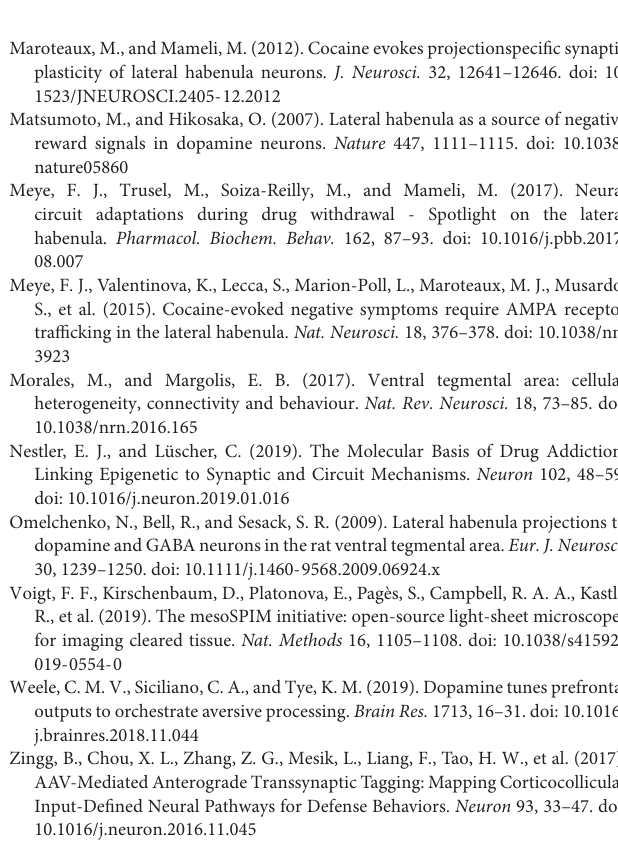
Synaptophysin expression throughout the mediolateral (ML, top) and Anterior-Posterior (AP, bottom) extent of the RMTg ( n hemispheres / mice = 3/2). Supplementary Figure 2 | 10Hz stimulation of LHb axons on to defined VTA populations. (A) VTA global: Sample traces (Saline: 100 ms, 20 pA; Cocaine: 100 ms, 20 pA) and normalized EPSC vs. pulse plots (saline n cells / mice = 27/10; cocaine n cells / mice = 29/14) Interaction factor F (9,486) = 1.148, P = 0.3272 two-way ANOVA Repeated Measures. (B) VTA-to-mPFC: Sample traces (Saline: 100 ms, 20 pA; Cocaine: 100 ms, 20 pA) and normalized EPSC vs. pulse plots (saline n cells / mice = 21/16; cocaine n cells / mice = 21/16) Interaction factor F (9,162) = 2.141, P = 0.0289 two-way ANOVA Repeated Measures. (C) VTA-to-NAc: Sample traces (Saline: 100 ms, 20 pA; Cocaine: 100 ms, 10 pA) and normalized EPSC vs. pulse plots (saline n cells / mice = 11/5; cocaine n cells / mice = 13/3) Interaction factor F (9,198) = 2.012, P = 0.0397 two-way ANOVA Repeated Measures. (D) VTA-to-LH: Sample traces (Saline: 100 ms, 10 pA; Cocaine: 100 ms, 100 pA) and normalized EPSC vs. pulse plots (saline n cells / mice = 23/5; cocaine n cells / mice = 24/6) Interaction factor F (9,405) = 1.417, P = 0.1786 two-way ANOVA Repeated